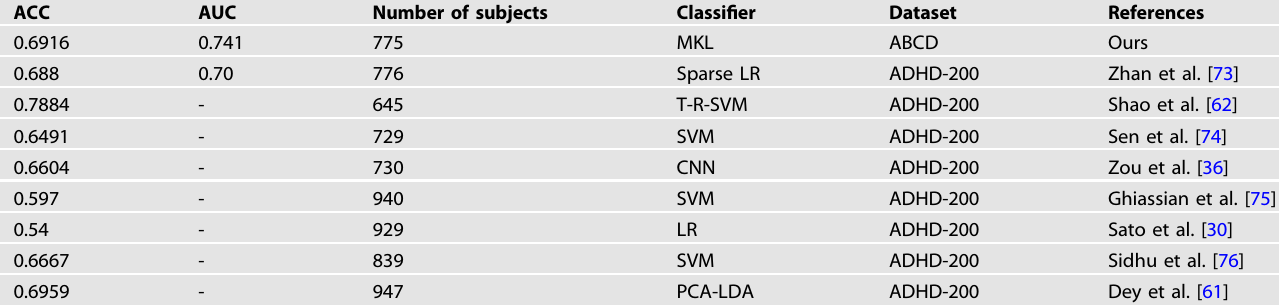
Table 5. Published resting-state fMRI-based ADHD classi fi cation